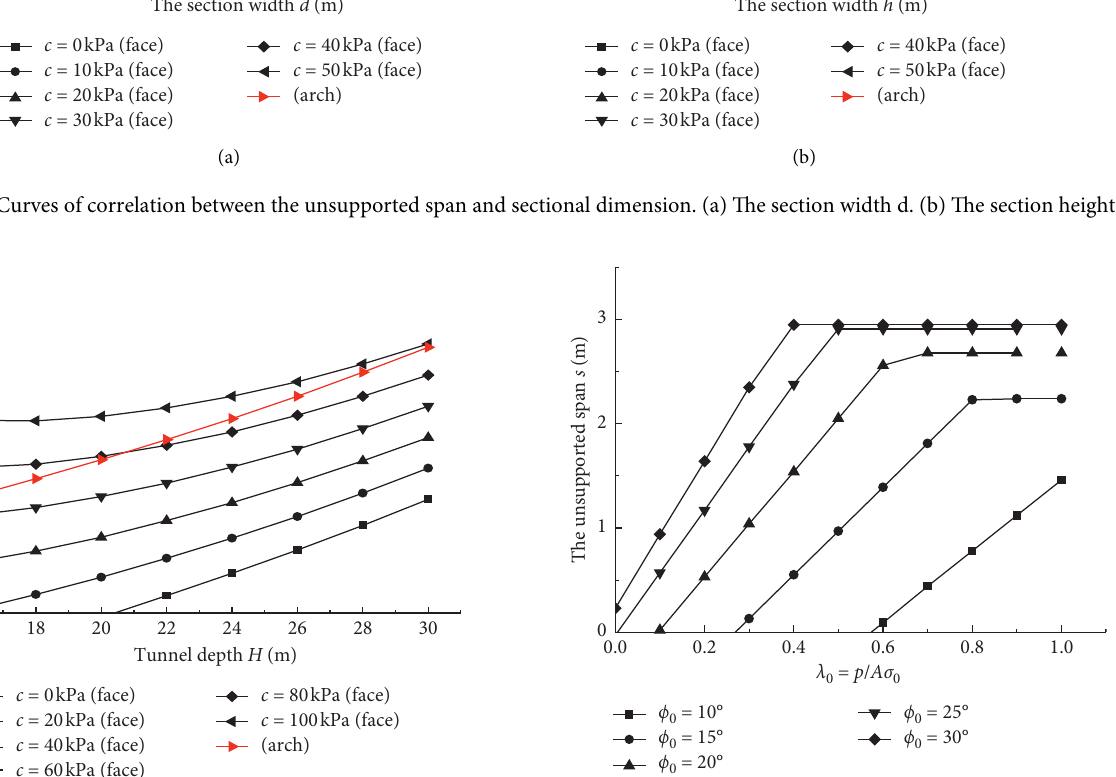
Figure 13: Curves of correlation between the unsupported span and depth of the tunnel.